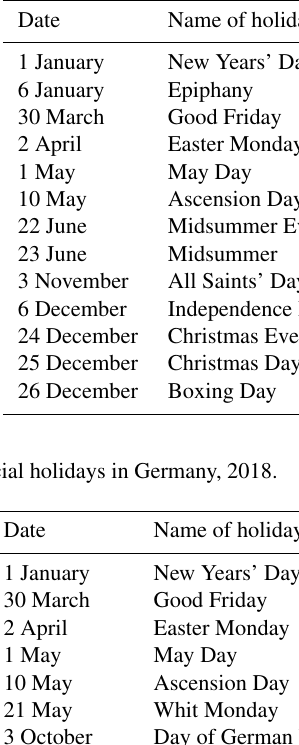
Table 3. Official holidays in Turkey,